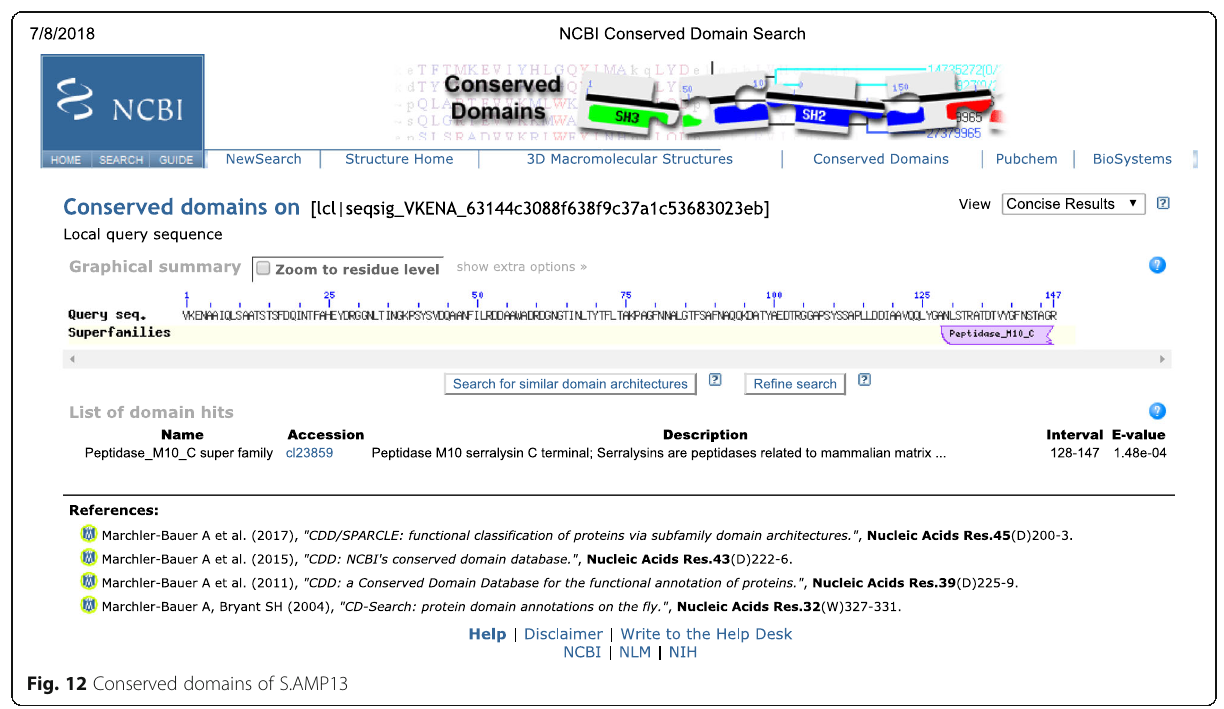
Fig. 12 Conserved domains of S.AMP13